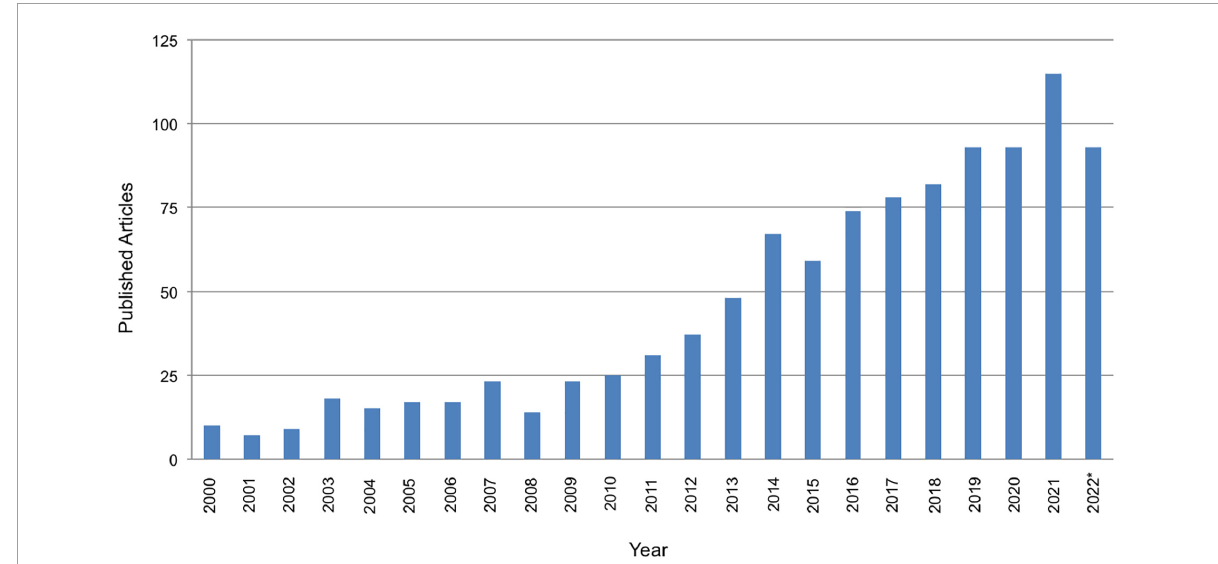
FIGURE1 PubMed search of published articles on by year January 1, 2000 to October 11, 2022 for transcranial AND cerebell* AND stimulation . Note that the total number of articles for year 2022 is lower as the year was not over at the time the search was